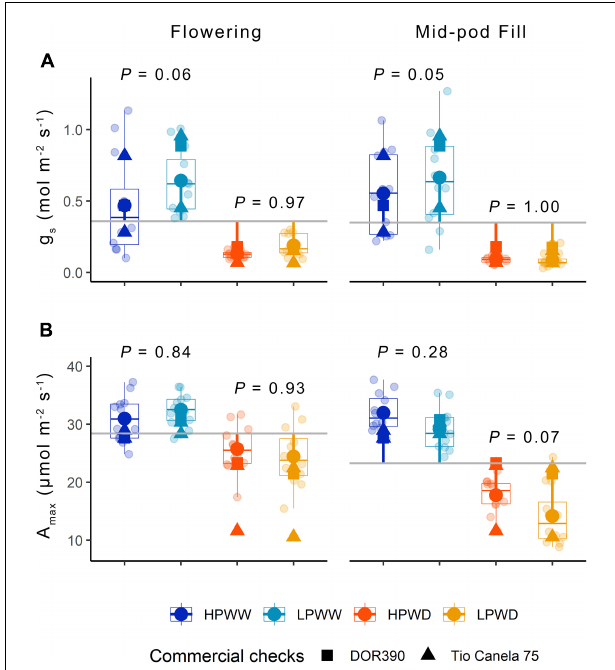
FIGURE 3 | (A) Stomatal conductance g s (mol/m 2 /s) and (B) A max ( µ mol/m 2 /s) for 12 common bean genotypes under treatments of low phosphorus well-watered (LPWW), high phosphorus well-watered (HPWW), low phosphorus water deficit (LPWD). and high phosphorus water deficit (HPWD) at flowering and mid-pod fill stages. Gray horizontal lines represent overall means across the different treatments; segment lines represent the mean difference of individual treatment relative to the overall means. P values are according to treatment means comparison calculated using HSD test at A = 0.05. Commercial checks are illustrated by square and triangle shapes. Multiple comparisons between treatments is provided in